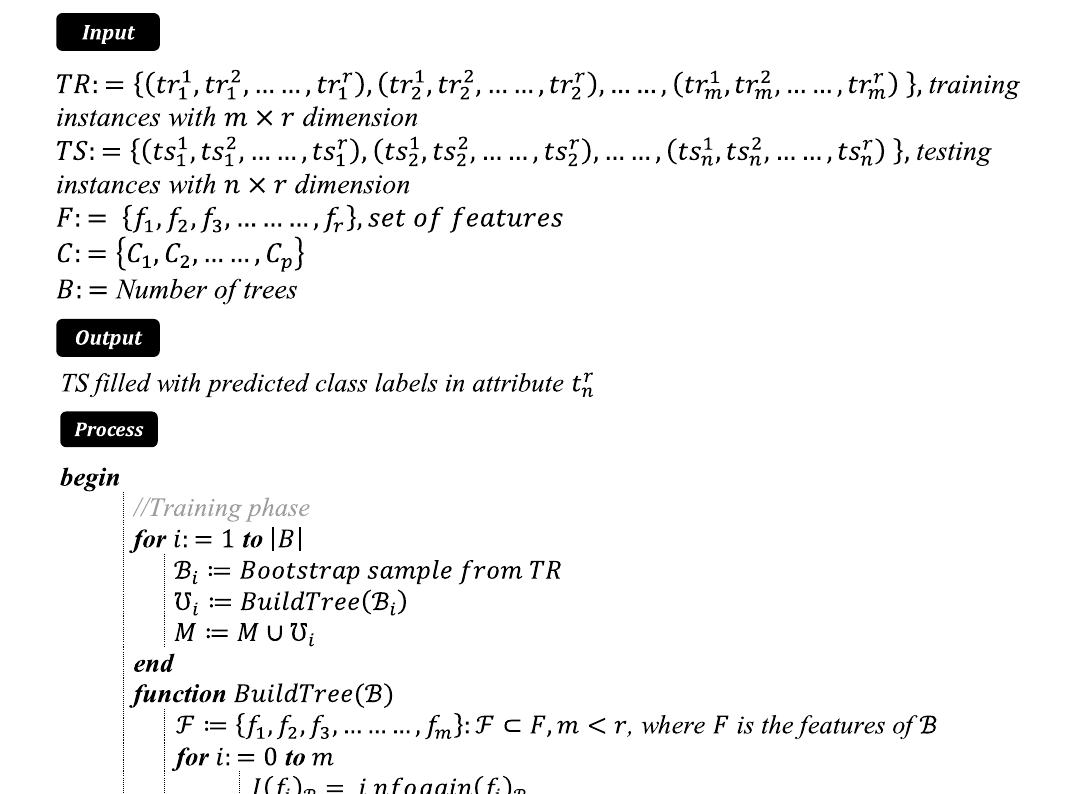
Table 3 Pseudocode of Adaboost Random